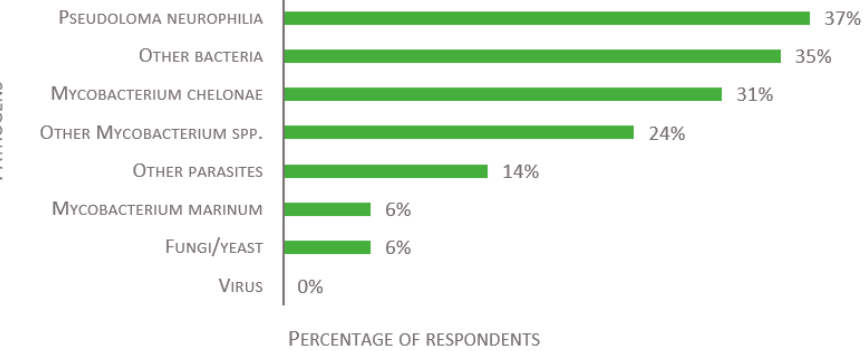
Figure 10. Replies to the open-ended question: “If you are allowed to share the information: which pathogens are present in your fish facility?”, presented as percentage of respondents ( n = 49).